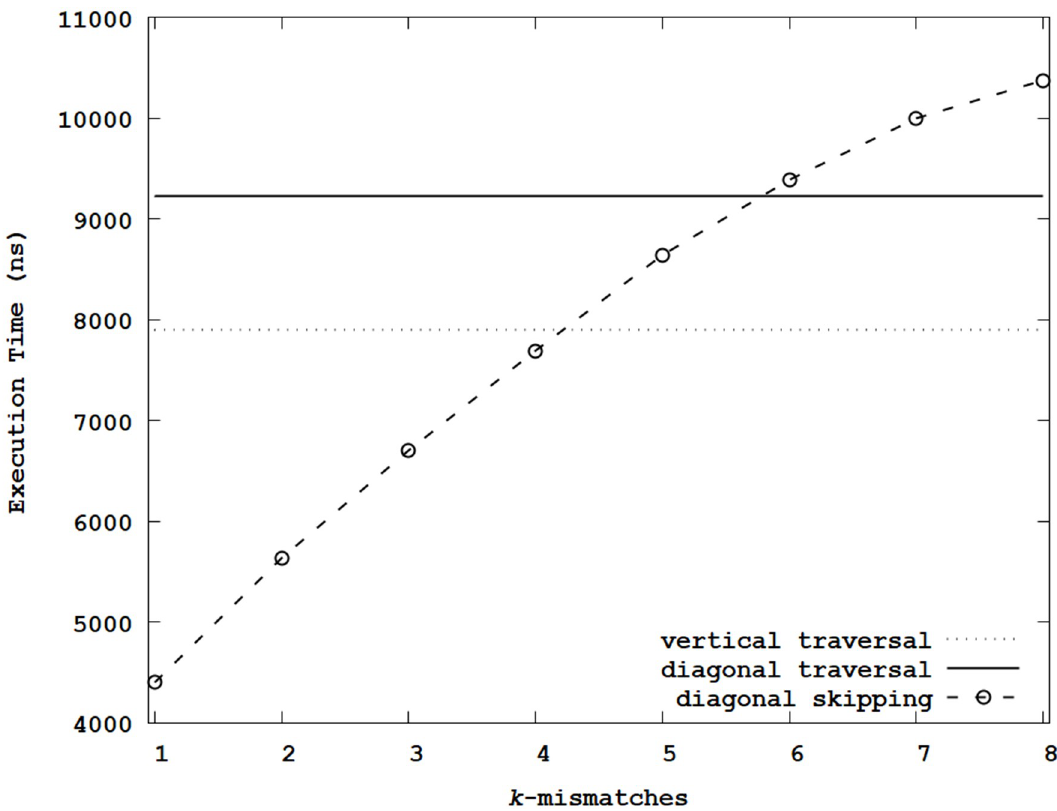
Fig 6. Average execution times of the Levenshtein distance